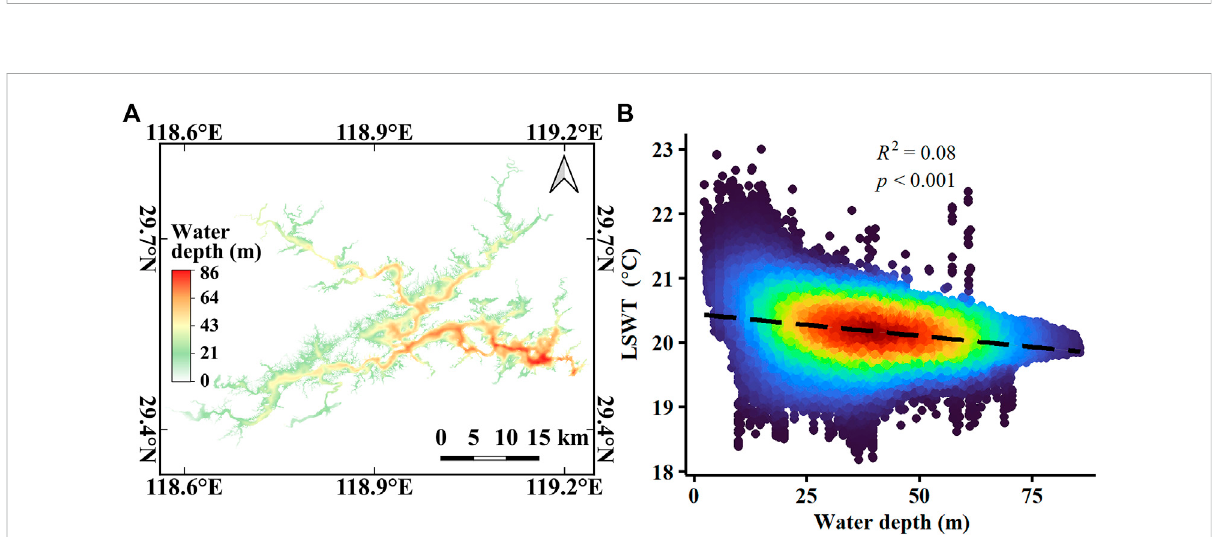
FIGURE 8 Water depths of Lake Qiandaohu (A) and scatter plot of the relationship between the water depth and 36-year averaged LSWT (B)